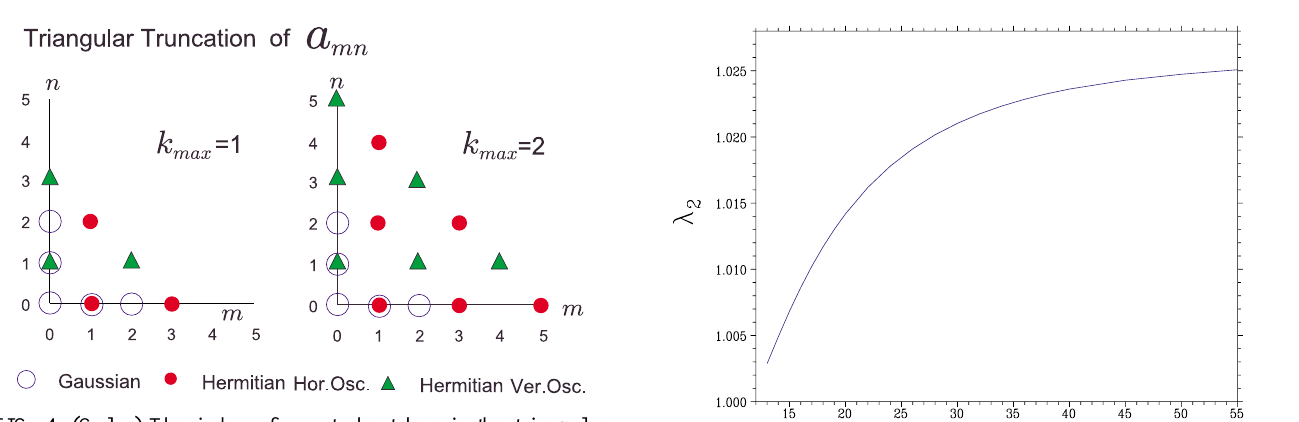
FIG. 4. (Color) The index of a mn to be taken in the triangular truncation for k max (cid:1) 1 and 2. The open circles indicate the terms already taken in the soft-Gaussian approximation, and the filled circles (triangles) indicate the terms needed to describe horizontal (vertical) oscillations in the triangular truncation.